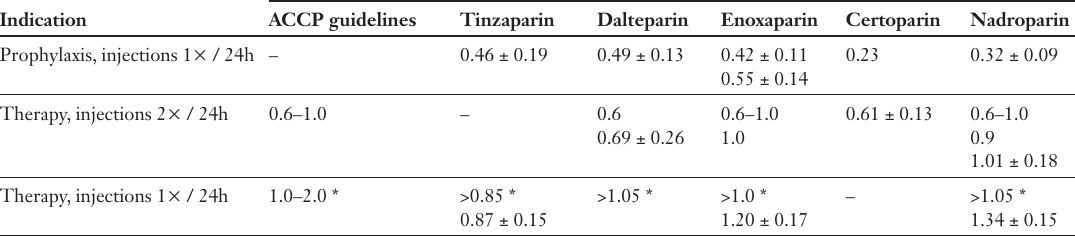
Target ranges of peak anti-Xa levels 4 hours after s.c. injection. Recommendations are shown for pro- phylaxis and therapy from the ACCP guide- lines [1, 3] and from pharmacokinetic studies reporting typ- ical values of specific LMWH [16, 27, 47, 84, 95, 118,